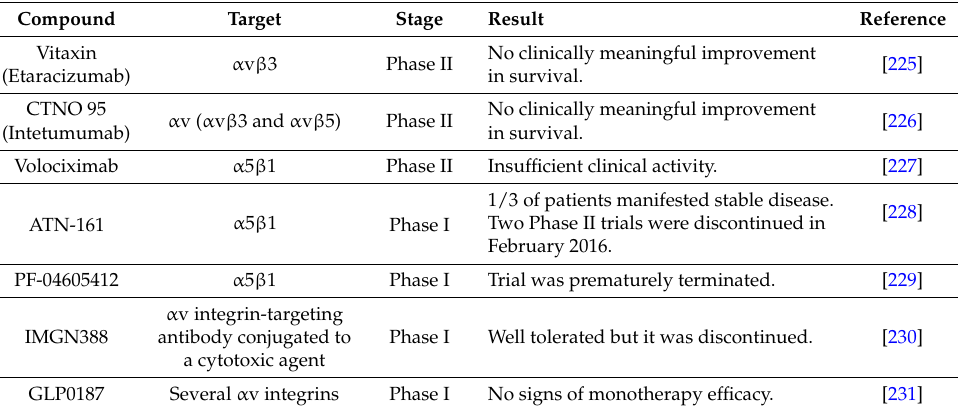
Table 3. Results of clinical trials targeting integrins in